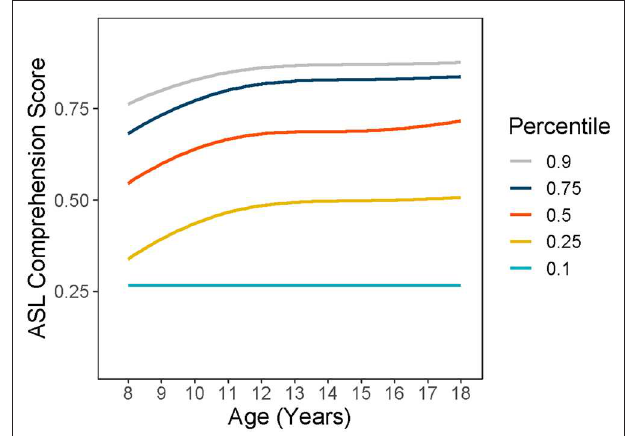
FIGURE 3 | The relationship between age and accuracy on the ASL-CMP for deaf children with deaf parents ( n = 105). Lines indicate the 10th, 25th, 50th, 75th, and 90th percentiles, and were generated using the gcrq function in the R package quantregGrowth. The graph is not intended to be used to classify children’s performance as within/above/below the normal